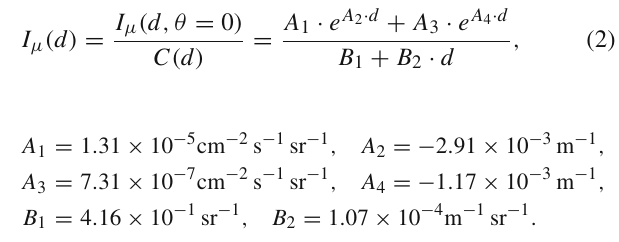
Fig. 9 Integrated atmospheric muon flux measured with the ORCA1 and ARCA2 detectors as a function of depth below the sea level (red points).Thesystematicerrorsaredisplayedaslightredshadowedareas. TheBugaevmodeloftheatmosphericmuonfluxisdrawnwithadashed black line (quoted errors are the grey shadowed area), see text for model description. ANTARES data from [22] are included as blue points for comparison (systematic errors are the light blue shadowed area). The depth is expressed in water equivalent (w.e.). Statistical uncertainties are included and smaller than